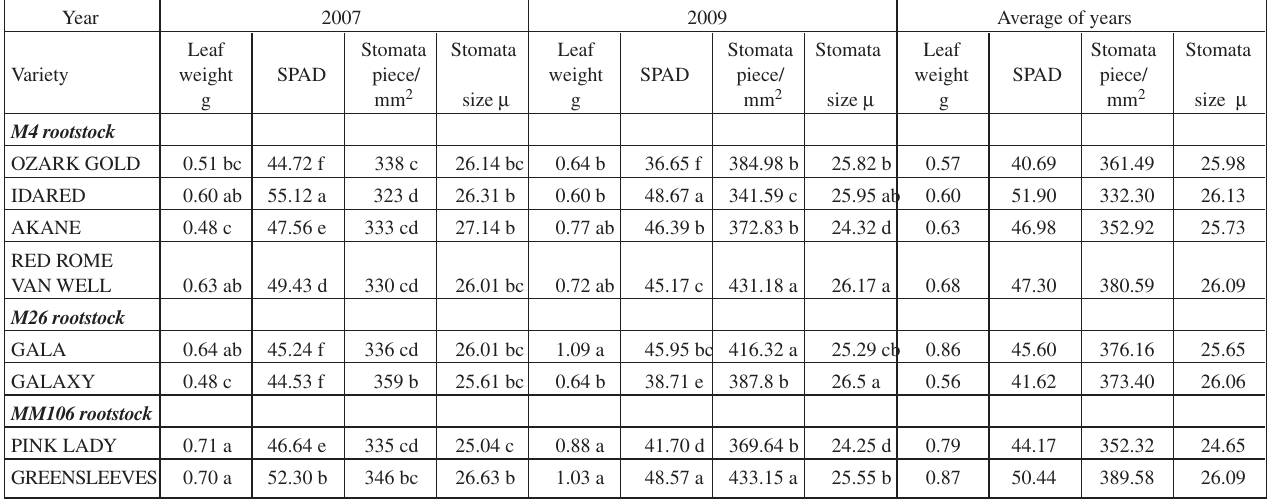
Table 1. Relative chlorophyll content (SPAD) and stomata density of apple leaves during fruit development non-irrigated